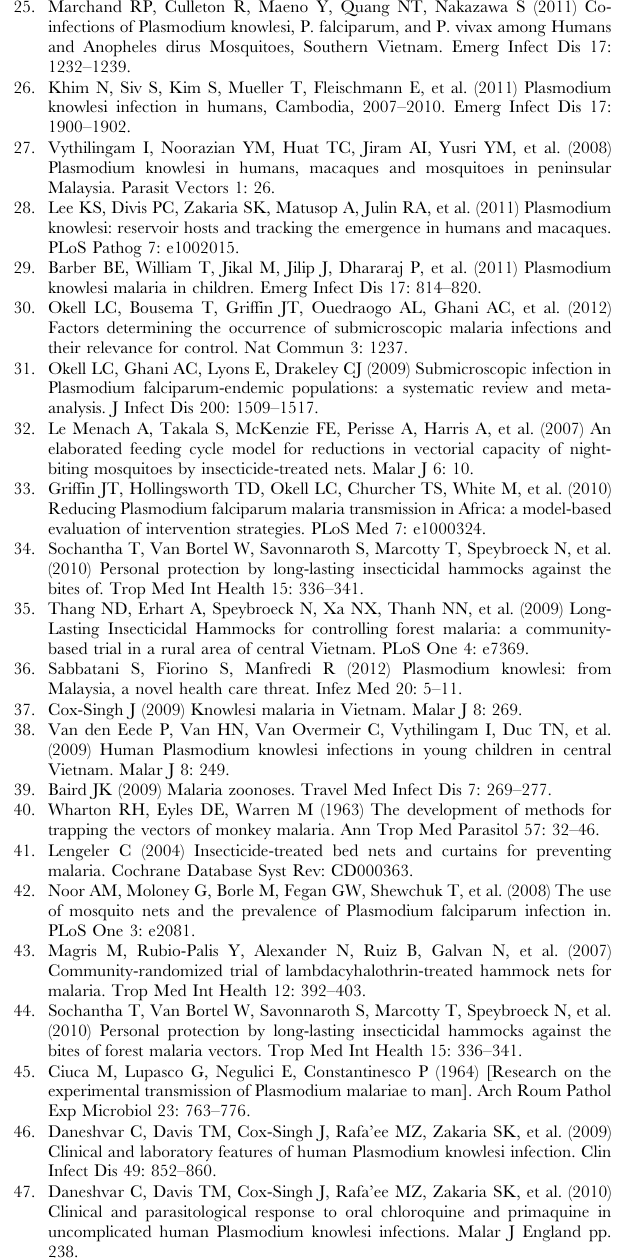
Table S1 Additional parameters and initial values. (DOCX) Text S1 Supplementary information containing full mathemat- ical details, and further results from sensitivity